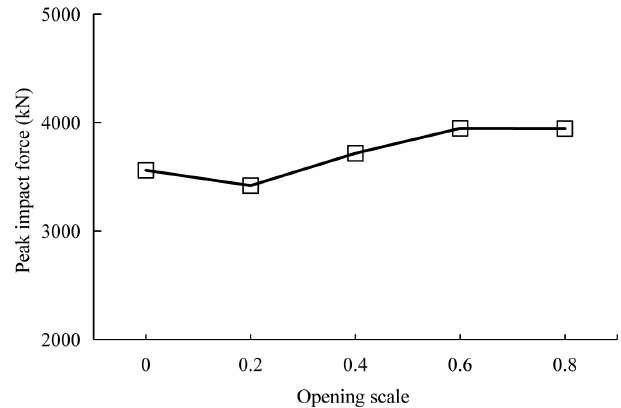
Figure 20. Peak impact forces change with the target building’s opening scale in the scenarios of Or90-Opx- A null- D